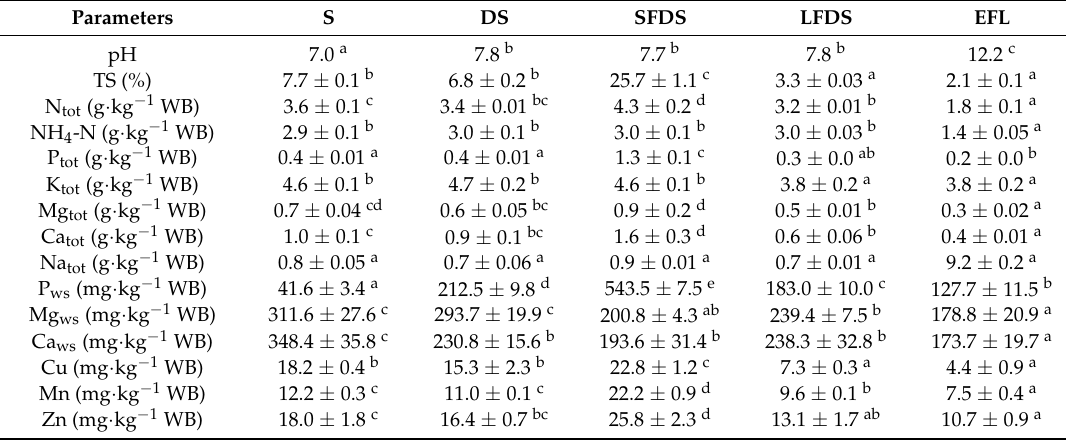
Table 1. The physicochemical properties of organic materials flowing through the farm scale bio-refinery. Parameters S DS SFDS LFDS EFL